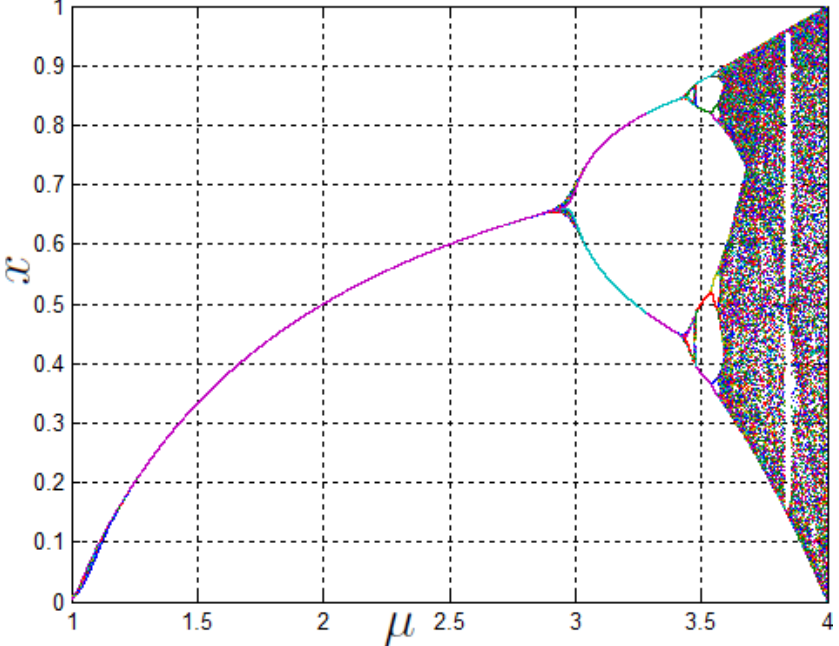
Figure 11. Bifurcation diagram of a logistic map: chaotic nature for µ ∈ ( 3.57,4 )